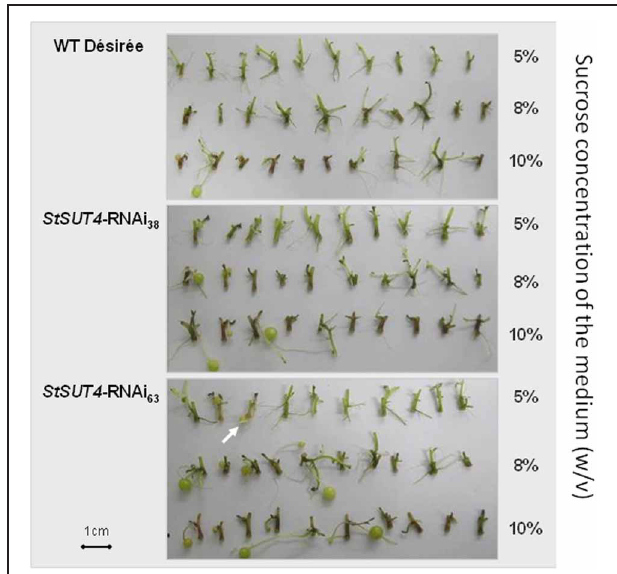
FIGURE 3 | Microtuber production in response to various sucrose concentrations in the dark. Stem cuttings from two independent transgenic lines (StSUT4-RNAi38 and StSUT4-RNAi 63) and WT potato plants from sterile tissue culture were transferred in MS-medium containing 5, 8, or 10% sucrose (w/v). Pictures were taken 10 days after transfer into the dark. The experiment was repeated three times independent experiments and one representative example is given. Note that microtuber production in the transgenic line StSUt4-RNAi #63 is induced by 5% sucrose (arrow). Microtuber induction experiments were performed with Solanum tuberosum ssp. tuberosum plants of the variety